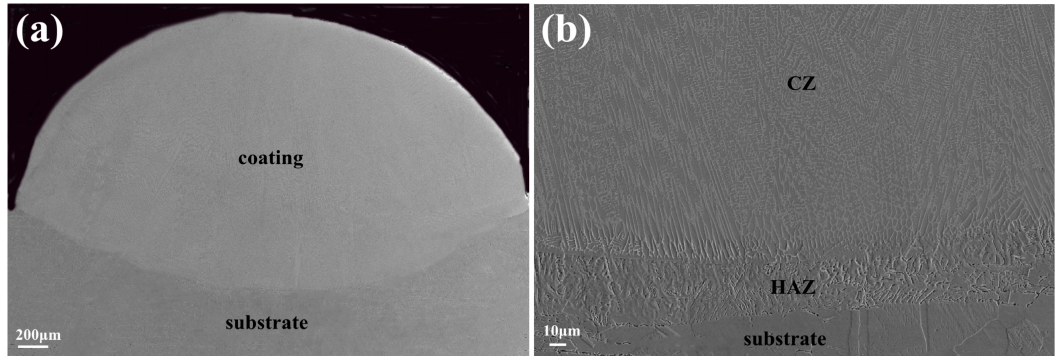
Figure 2. The typical macroscopic morphology in the cross-section of the HEA coating ( a ) overall morphology, ( b ) cross-sectional view.